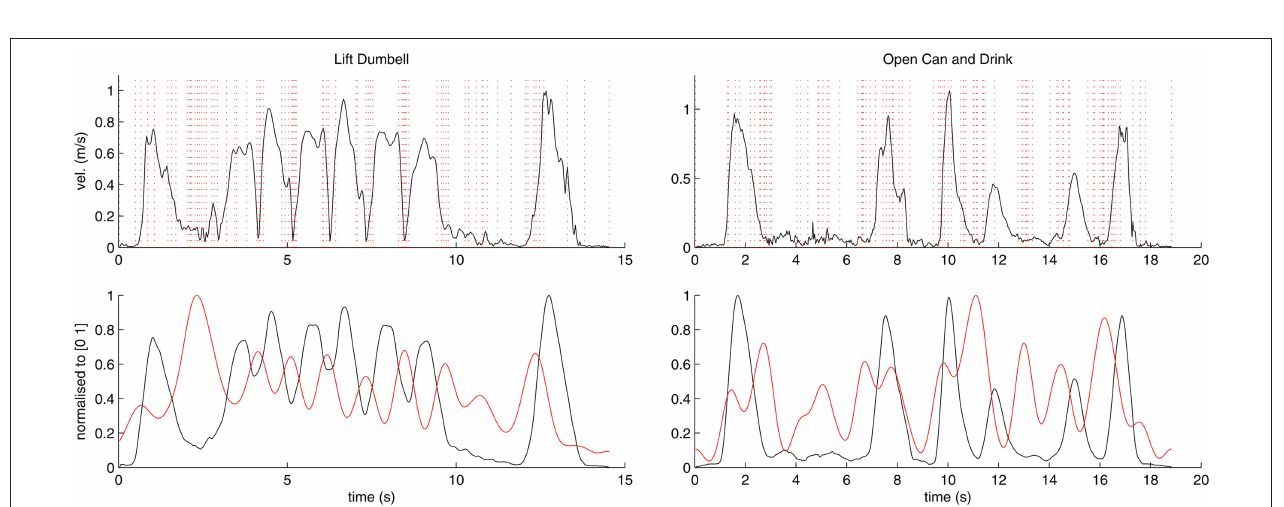
Figure 6 | Computation of the correlation coefficients between participant responses and kinematic data. The top row shows raw velocity data and marks placed by participants from group 1 (pictures) for two actions; lift dumbbell (left) and open can and drink (right). The bottom row shows the